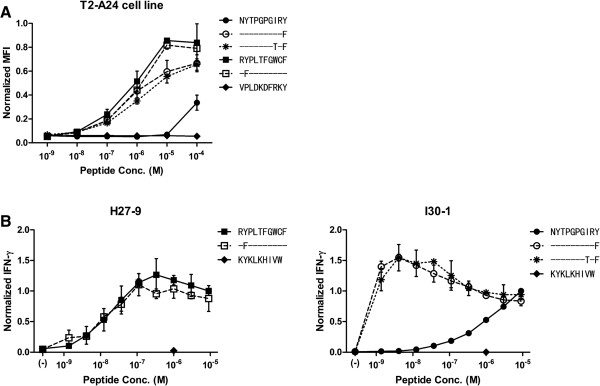
Epitope characterization. (A) Binding affinity of each peptide to HLA-A*24:02 was tested by using T2-A24 cell line. All peptides except negative control peptide, VPLDKDFRKY, which might not bind to HLA-A*24:02, show HLA-A*24:02 binding in the peptide concentration of 10-4 M. Each point and bar represents the average and the standard deviation of normalized MFI from three independent experiments. (B) 293FT-A24DRm-CY0 cells were pulsed with serially diluted peptides and co-cultured with CTL clones specific to Nef134-10 (H27-9) or Nef126-10 (I30-1). Epitope recognition was determined by normalizing quantity of IFN-γ secretion. For normalization, all values were divided by IFN-γ secretion with wild type peptide concentration of 9 μM. Neither clone showed specificity to the negative control, Gag28-9 peptide (KYKLKHIVW) a binder of HLA-A*24:02. Each point and bar show average and standard deviation of three independent experiments.